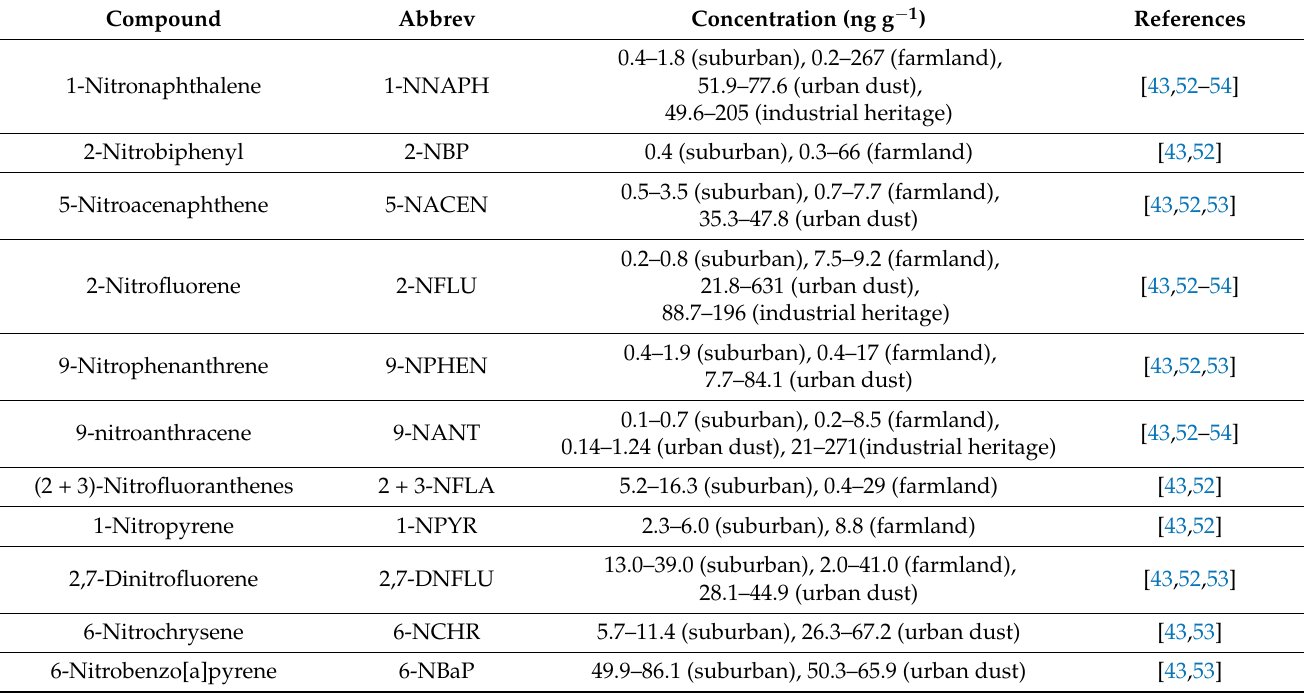
Table 3. Research status of individual NPAH in